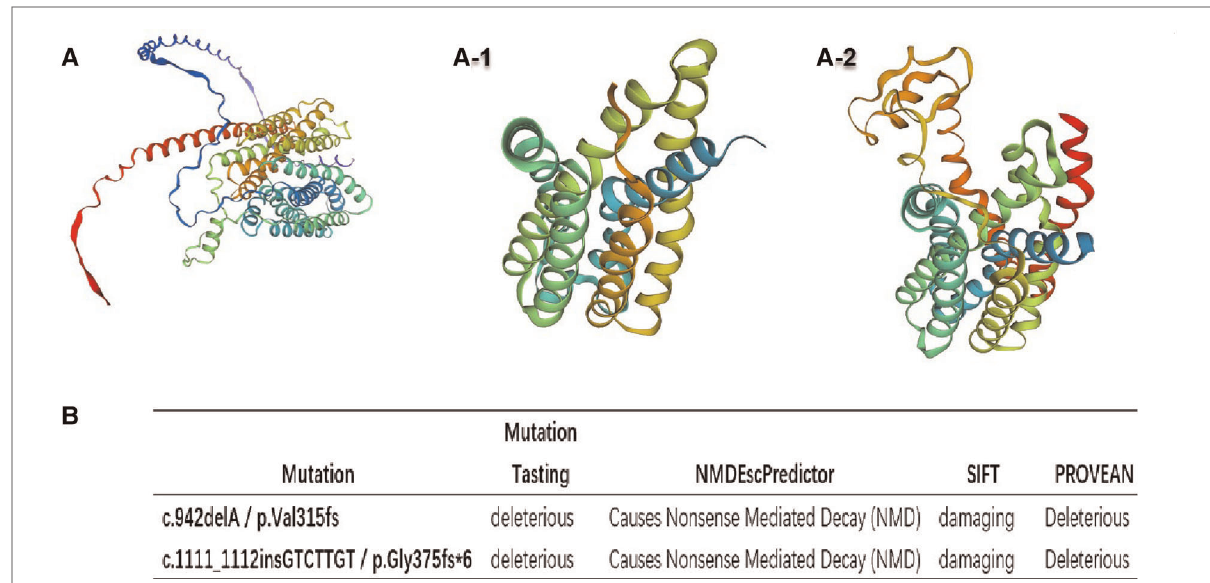
FIGURE 3 The three-dimensional structure modeling predicts a decrease in protein length with ( A ) as the wild-type and ( A-1 ) and ( A-2 ) as the mutant-types ( A-1 : p. Val315fs*28; A2: p. Gly375fs*6), respectively. ( B ) The effects of these variants were predicted using four different software